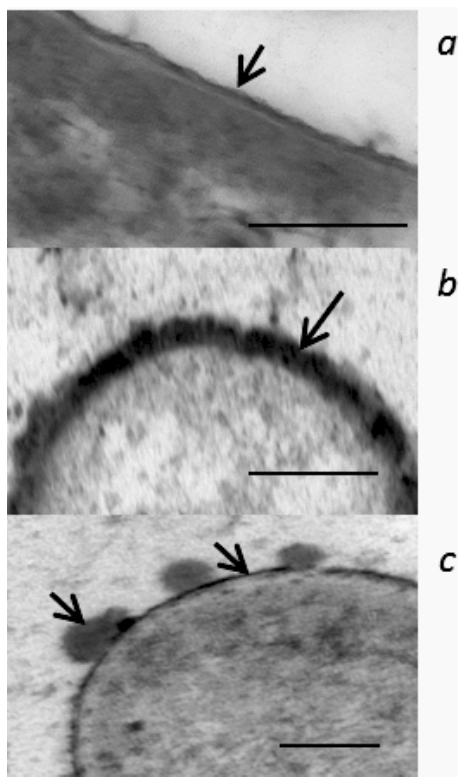
Figure 6. Effect of CT isolated from purple prairie clover (PPC; Dalea purpurea Vent.)